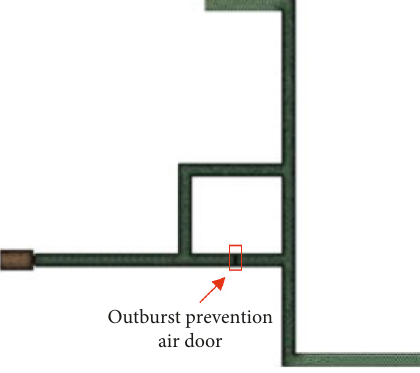
Figure 1: Meshing of the geometric model. Table 1: Model initialization parameter